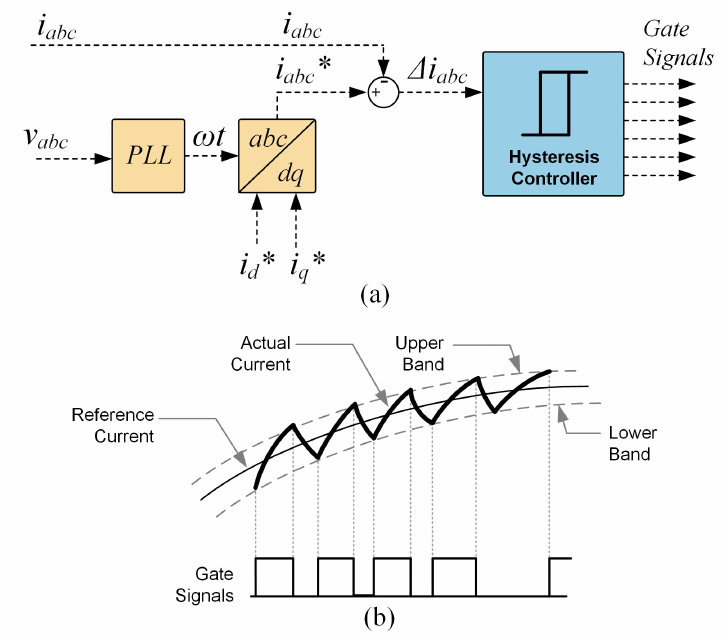
Figure 4. Hysteresis current controller. ( a ) Schematic diagram. ( b ) gate signal